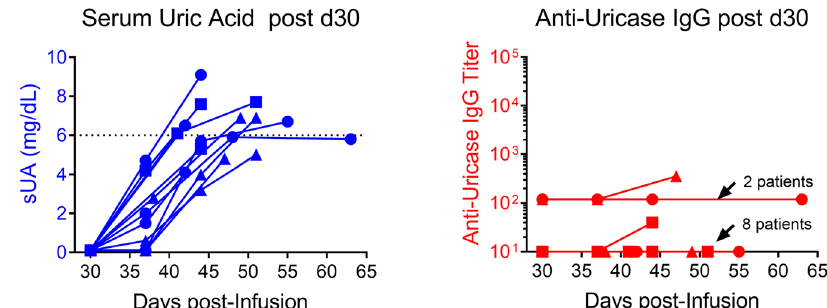
Fig. 5 Serum uric acid and anti-uricase IgG for selected patients followed past day 30. Patients in cohorts G, H, and I that maintained sUA levels below 6 mg/dL for 30 days were selected on a voluntary basis to participate in additional monitoring. Serum uric acid and anti-uricase IgG titers are plotted for individual patients at various timepoints indicated. Patients in cohorts G, H, and I are represented by circle, square, and triangle symbols, respectively. All patients showed a rebound in sUA levels by day 50, indicating clearance of enzyme. Ten of the twelve patients showed no increase in anti-uricase IgG titers after day 30 and the remaining two patients showed only modest elevations in anti-uricase IgG titers. Source data are provided as a Source Data